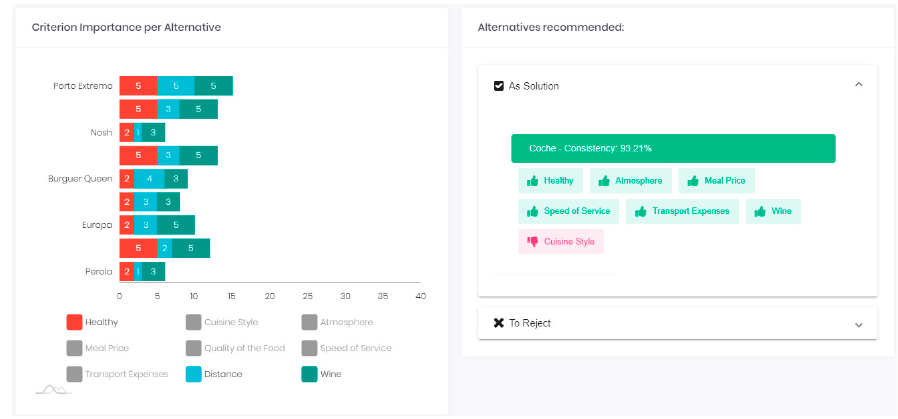
Figure 4. Graphs/elements of the “General Information” screen. Figure 4. Graphs / elements of the “General Information”